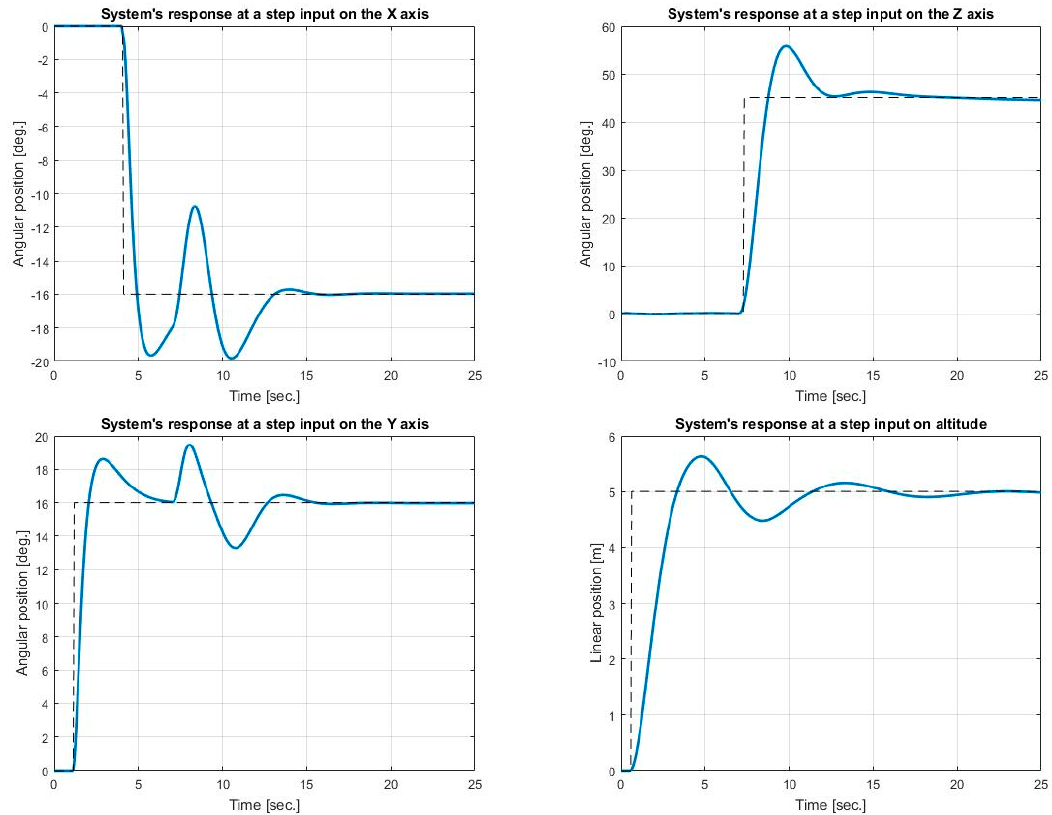
Figure 10. Measured output for the three degree of freedom: ( a ) pitch; ( b ) roll; ( c ) yaw.